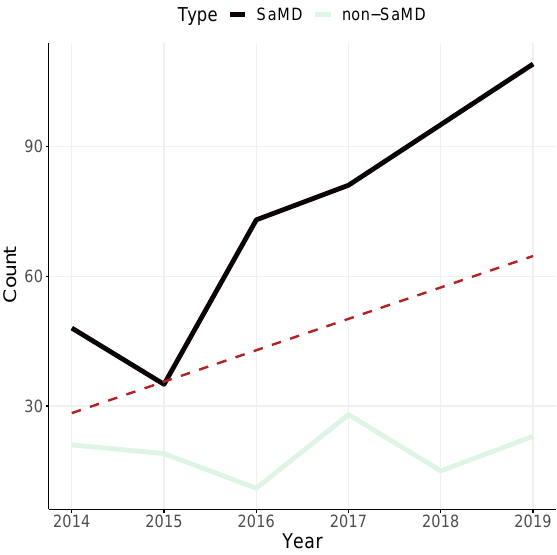
Figure 1. Times series comparison of software-as-a-medical-device (SaMD) and “software that incorporated into a medical device” (non-SaMD) based on the registrations in the ARTG over a period ranging from 2014–2019 ( n = 558). The dotted red line represent the lowess regression smoothing of all the time series